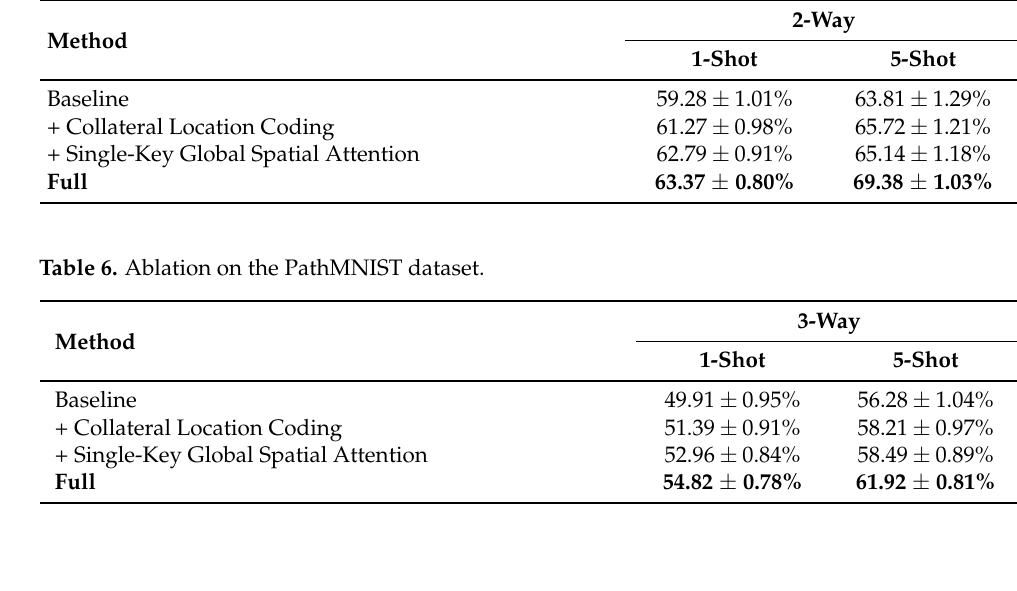
Table 5. Ablation on the DermaMNIST dataset.